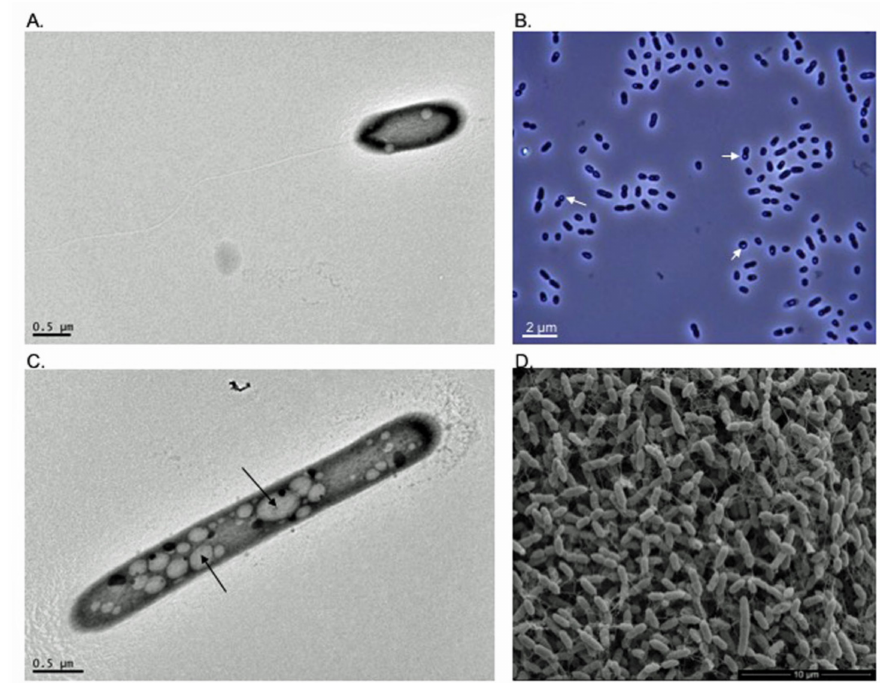
Figure 2. ( A ) Transmission electron micrograph of a cell of strain HW T2.11 T ( Acidisoma silvae ) with a polar flagellum; ( B ) phase contrast micrograph of cells of strain HW T2.11 T showing clear refractive intracellular granules of poly- β -hydroxybutyrate (PHB). White arrows indicate granules of PHB; ( C ) transmission electron micrograph of a cell of strain HW T2.11 T with intracellular granules of PHB. Black arrows indicate granules of PHB; ( D ) scanning electron micrograph of cells of strain HW T5.17 T ( A. cellulosilytica ) showing filamentous structures connecting cells and cells dividing by constriction. Strains HW T2.11 T and HW T5.17 T grow at temperature ranges of 8–25 ◦ C and A. tundrae (WM1 T ) and A. sibiricum (TPB606 T ) grow at lower temperatures (i.e., 2 ◦ C)